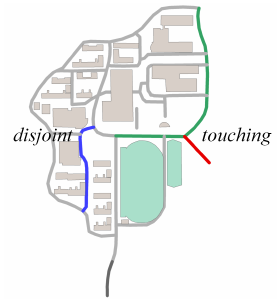
Figure 9. Topological relationships between roads. TR between the green and red roads corresponds to the touching facet. TR between the blue road and the two other roads (green and red) corresponds to a disjoint